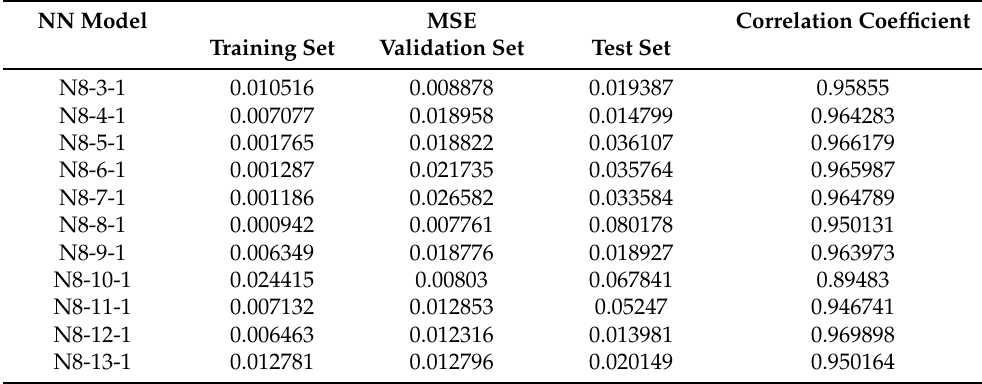
Table 1. Performance value of Yield Strength.